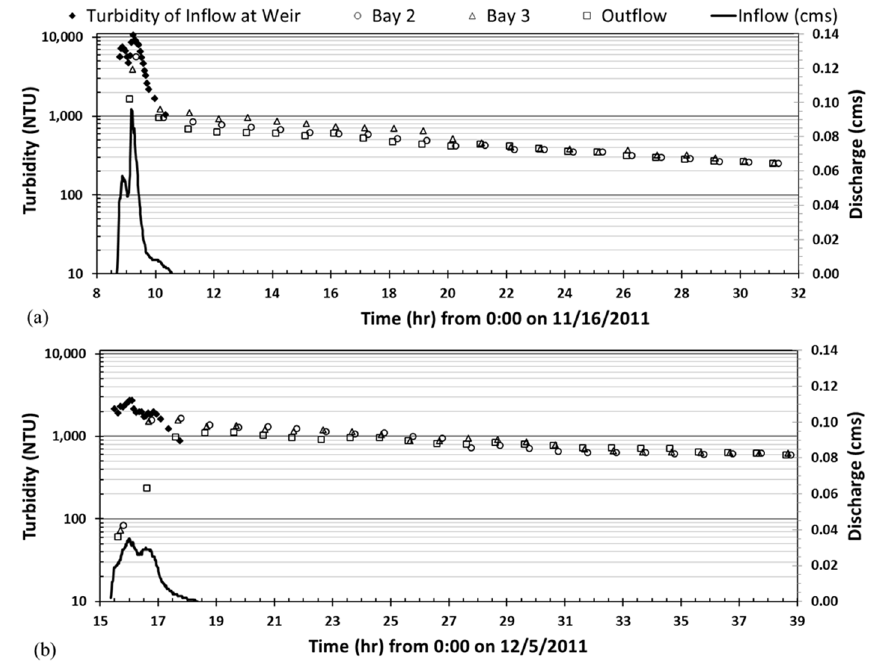
Figure 3. Time-series plots of inflow discharges (cms or m 3 /s) and measured turbidity (NTU) from stormwater samples collected at the inflow weir, Bay 2, Bay 3, and outflow of the basin: ( a ) for 16 November 2011 rain event and ( b ) for 15 December 2011 rain event during Phase